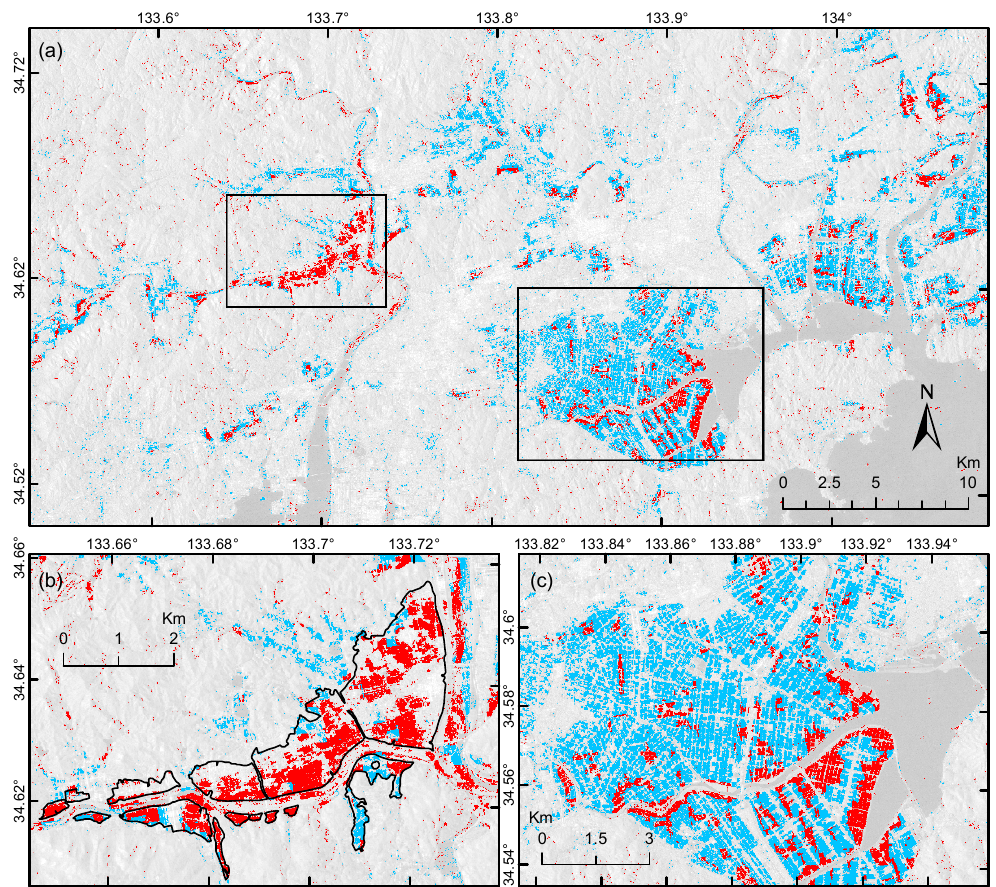
Figure 11. ( a ) EM classification of flooded (red pixels) and non-flooded (cyan pixels) agricultural targets. ( b ) Closer look of the F-area. The black polygons represent the flooded area provided by GSI. ( c ) Closer look at the